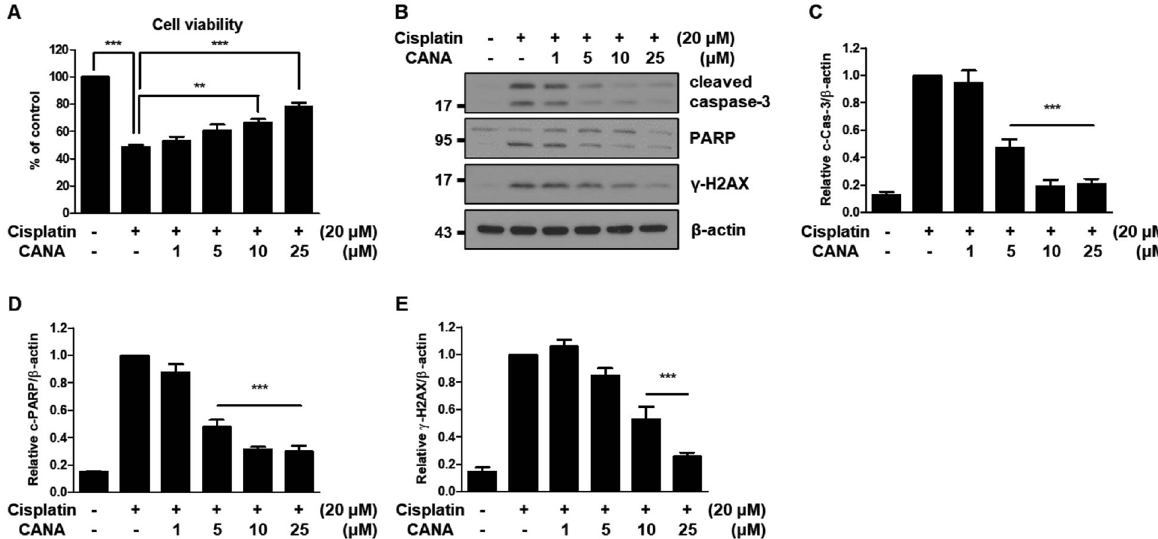
Fig. 1 Canagli fl ozin protects HK-2 cells from cisplatin by inhibiting apoptosis. Human renal proximal tubular (HK-2) cells were treated with 20 μ M cisplatin in the absence or presence of canagli fl ozin (CANA) at the indicated concentrations for 24 h. A Cell viability was evaluated via CCK-8 assay. Data are expressed as mean ± SD ( N = 4). Differences between groups were evaluated using one-way ANOVA followed by Bonferroni ’ s multiple comparison test. ** P < 0.01, *** P < 0.001, signi fi cantly different from the cisplatin-only treated group. B Representative immunoblot analysis. C – E Densitometric analysis of immunoblots to estimate the relative abundance of indicated molecules as normalized to that of β -actin. Data are expressed as mean ± SD ( N = 3). Differences between groups were evaluated using one-way ANOVA followed by Bonferroni ’ s multiple comparison test. *** P < 0.001, signi fi cantly different from the cisplatin-only treated